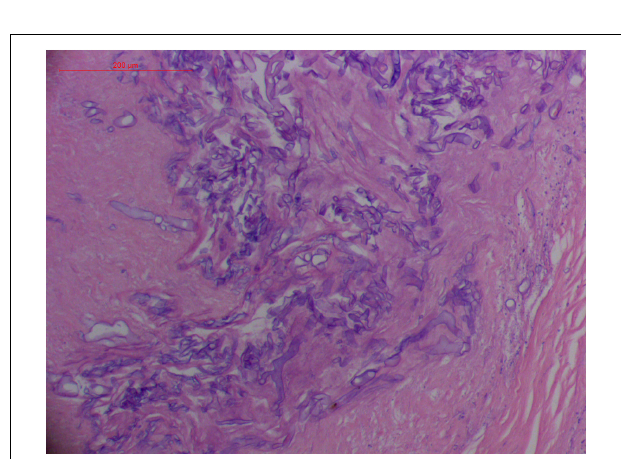
FIGURE 4 | Branched and septate hyphae of Penicillium sp. in the cavernous sinus of rhino-orbital-cerebral mycosis (periodic acid-Schiff staining, original magnification ×